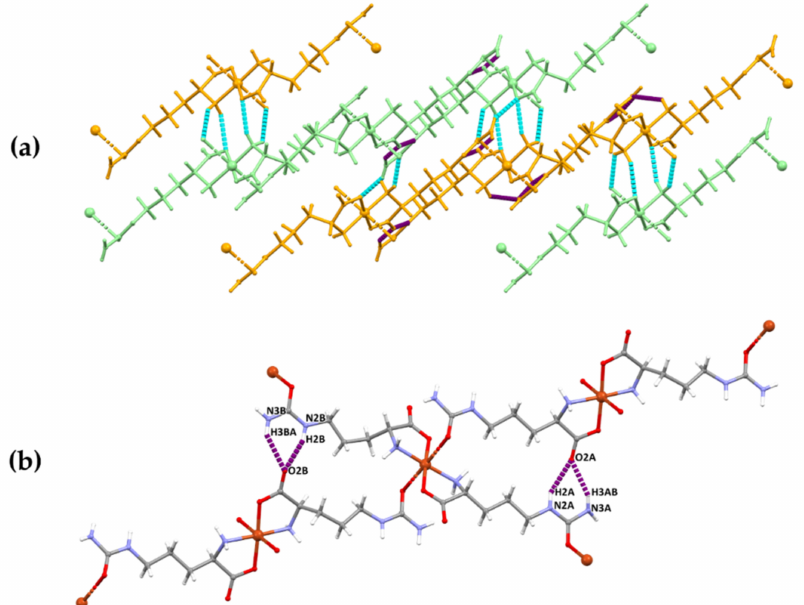
Figure 2. Crystal structure of the compound [Cu(Citr) 2 ] n along a and b crystallographic axis. The plane [202] is shown in green color. Hydrogen atoms have been omitted for clarity.